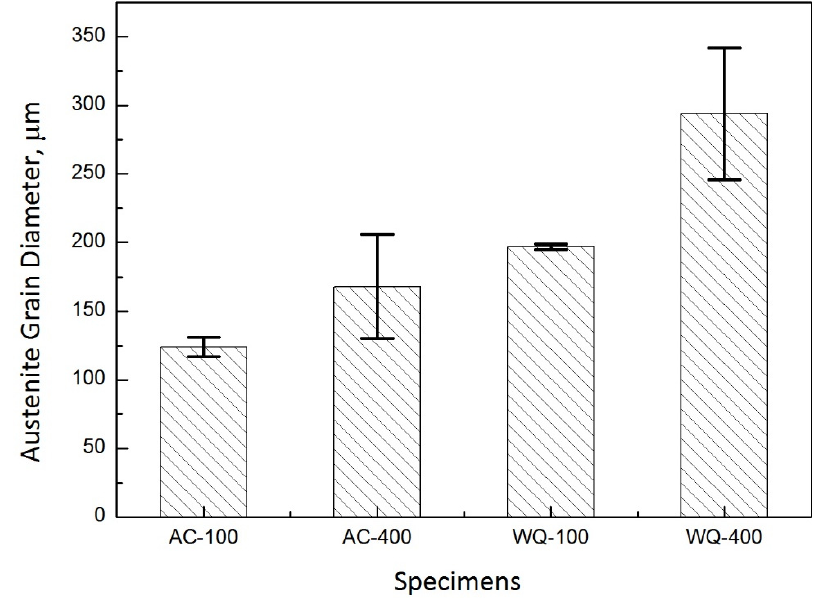
Figure 3. Prior austenite grain diameters in the CGHAZ with heat input of 100 kJ/cm and 400 kJ/cm. AC-100 is CGHAZ with 100 kJ/cm in air-cooled initial microstructure; AC-400 is CGHAZ with 400 kJ/cm in air-cooled initial microstructure; WQ-100 is CGHAZ with 100 kJ/cm in water-quenched initial microstructure; WQ-400 is CGHAZ with 400 kJ/cm in wa- ter-quenched initial microstructure.